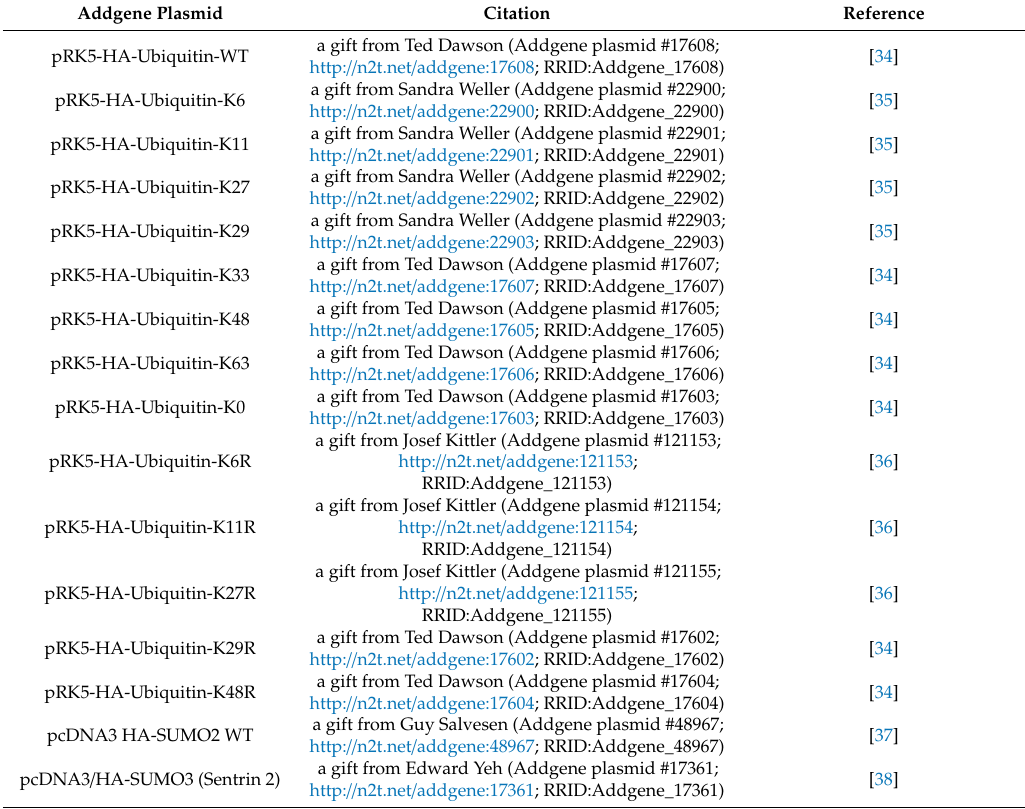
Table 1. The list of plasmids obtained from